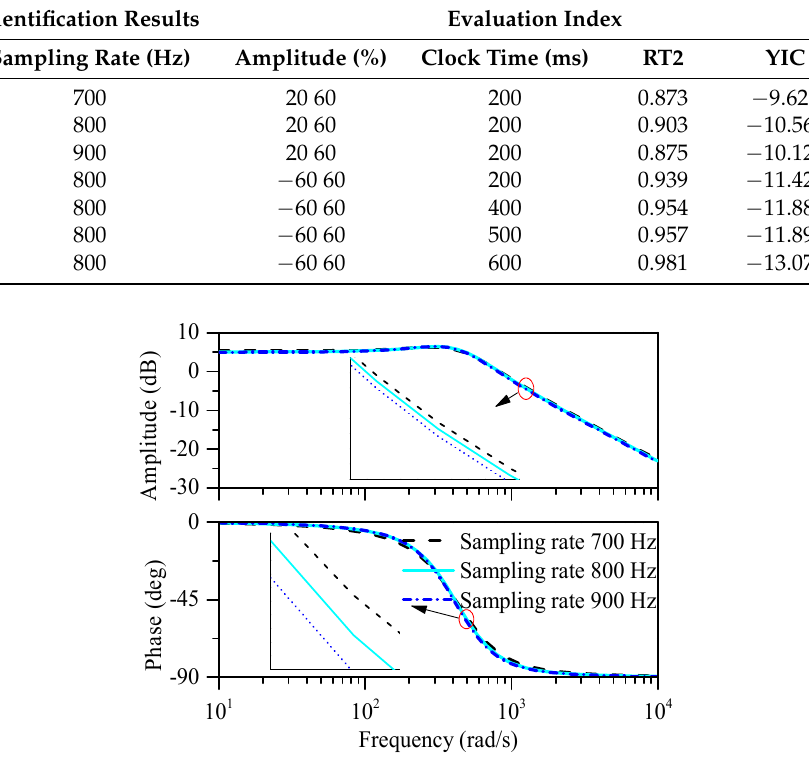
Algorithms 2019 , 12 , x FOR PEER REVIEW Figure 8. Bode plot of the identified motor under different sampling rates. Figure 8. Bode plot of the identified motor under different sampling rates.